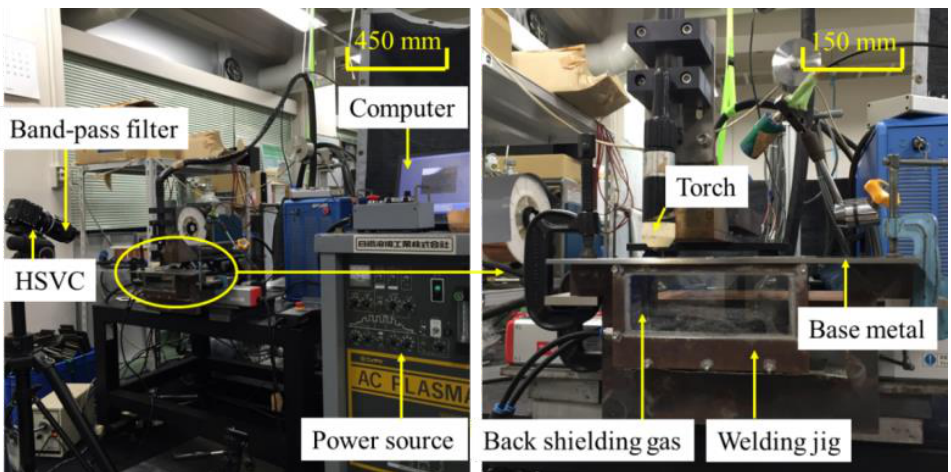
Figure 1. Photograph of the experimental setup.